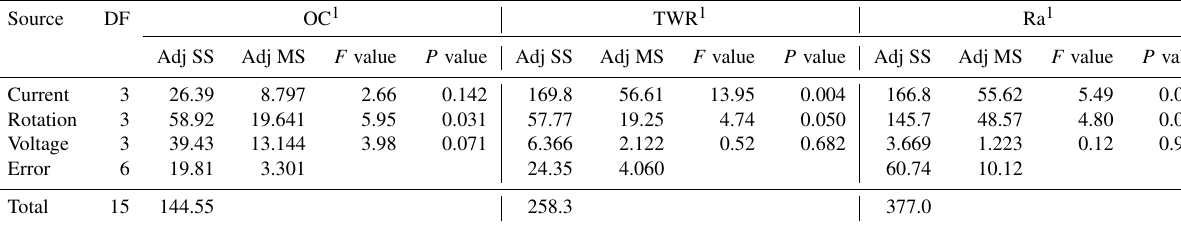
Table 7. Analysis of variance (ANOVA) for S/N ratio of cryogenic electrode.